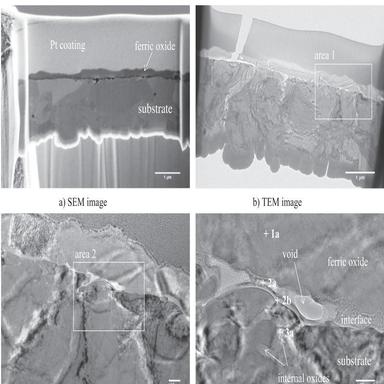
TEM EDS elemental mapping of the oxidized sample. a) SEI, b) Fe, c) O, d) Mn, e) Si.